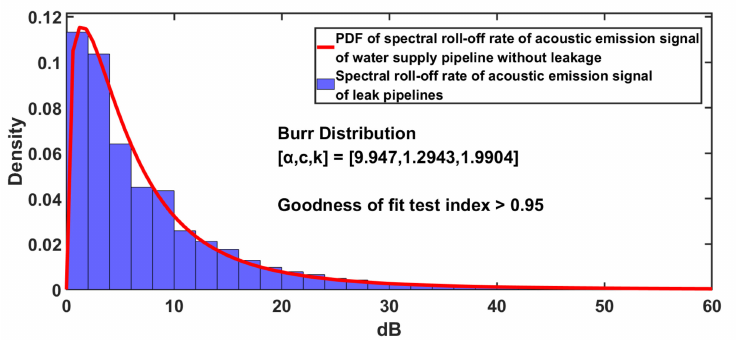
Figure 10. Distribution of the spectral roll-off rates of the acoustic emission signals of pipelines without a